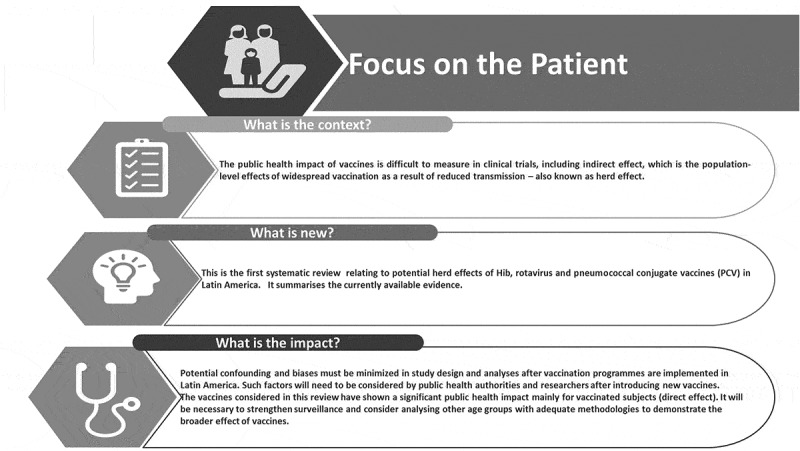
Outcomes and the impact of this study for healthcare providers.